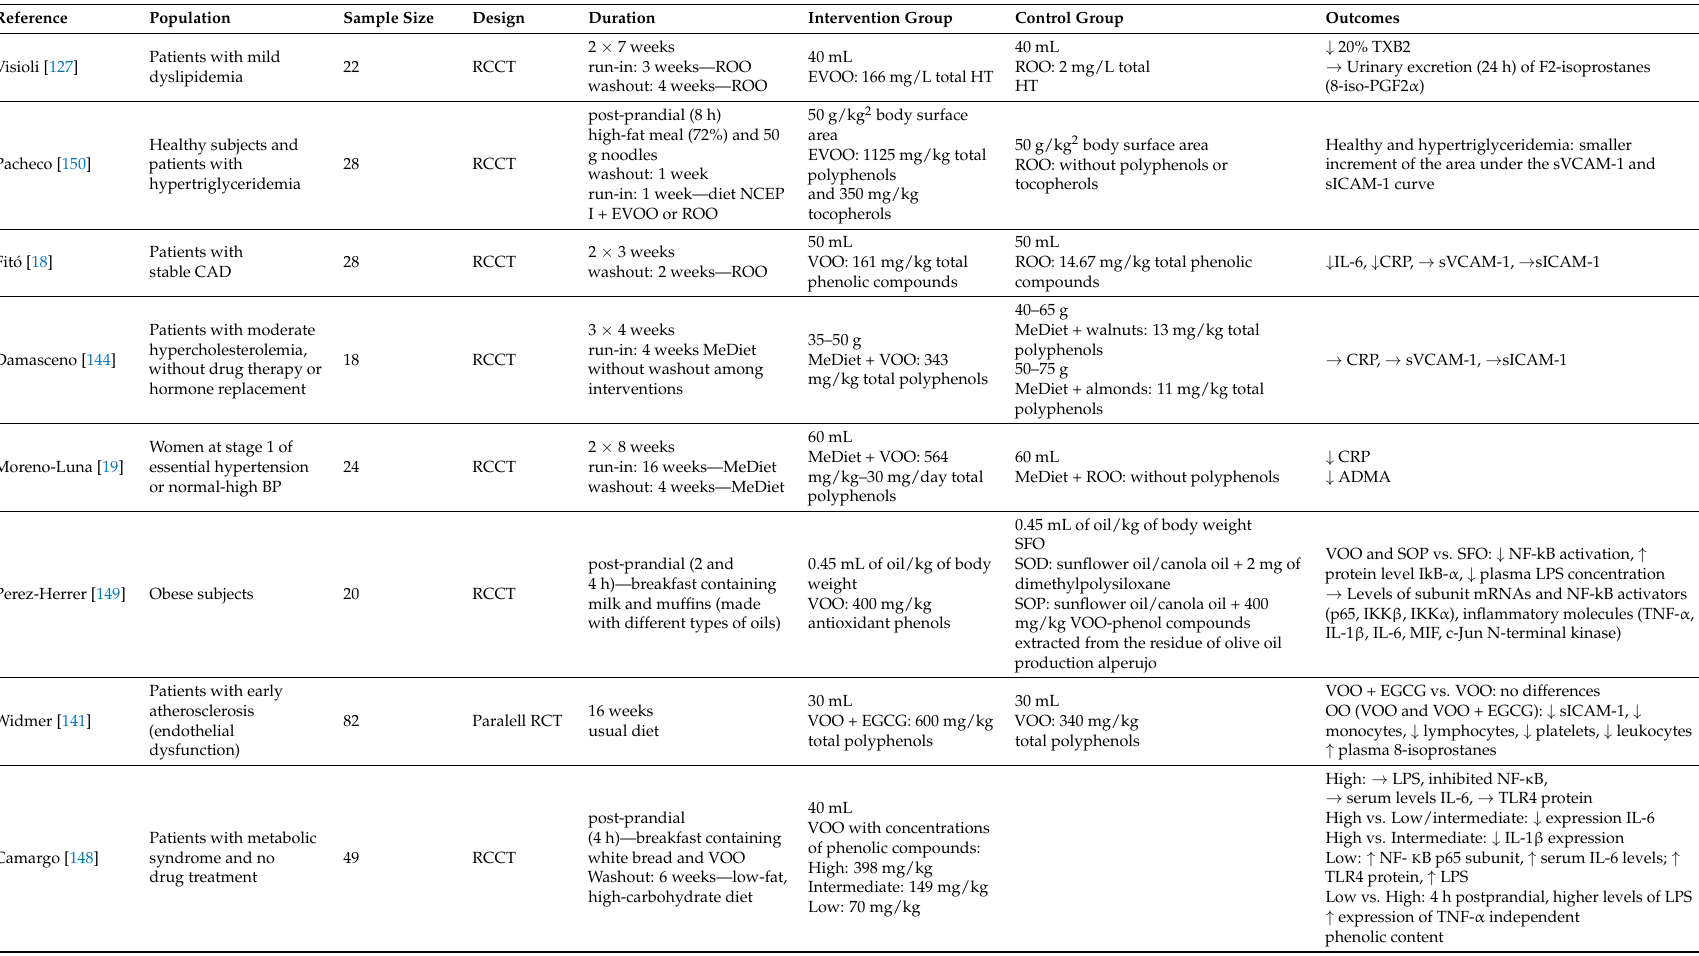
Table 2. Clinical trials that evaluated the effect of different concentrations of olive oil phenolic compounds on inflammatory markers in patients with cardiovascular risk and